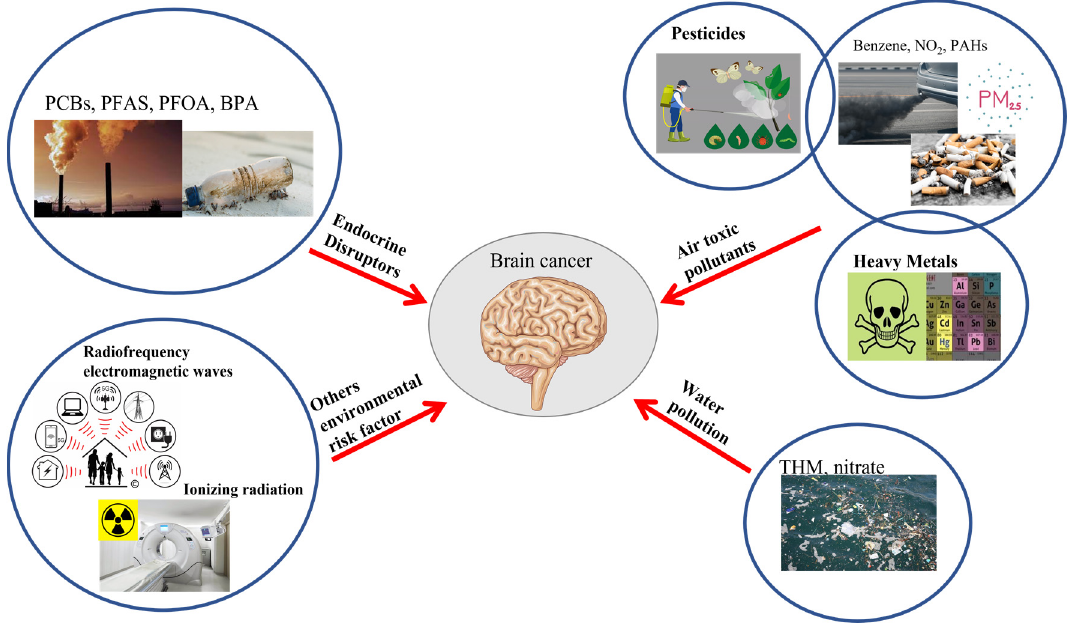
Figure 1. Schematic representation of the action of different environmental pollutants on brain cancer. Endocrine disruptors; PCBs: polychlorinated biphenyls; PFAS: polyfluoroalkyl substances; PFOA: perfluorooctanoic acid; BPA: bisphenol A; THM: trihalomethanes; NO 2 : nitrogen dioxide; PAHs: polycyclic aromatic hydrocarbons; PM2.5 µm: particulate matters; Heavy metal; Ionizing radiation; RF: radiofrequency radiation [36–44].